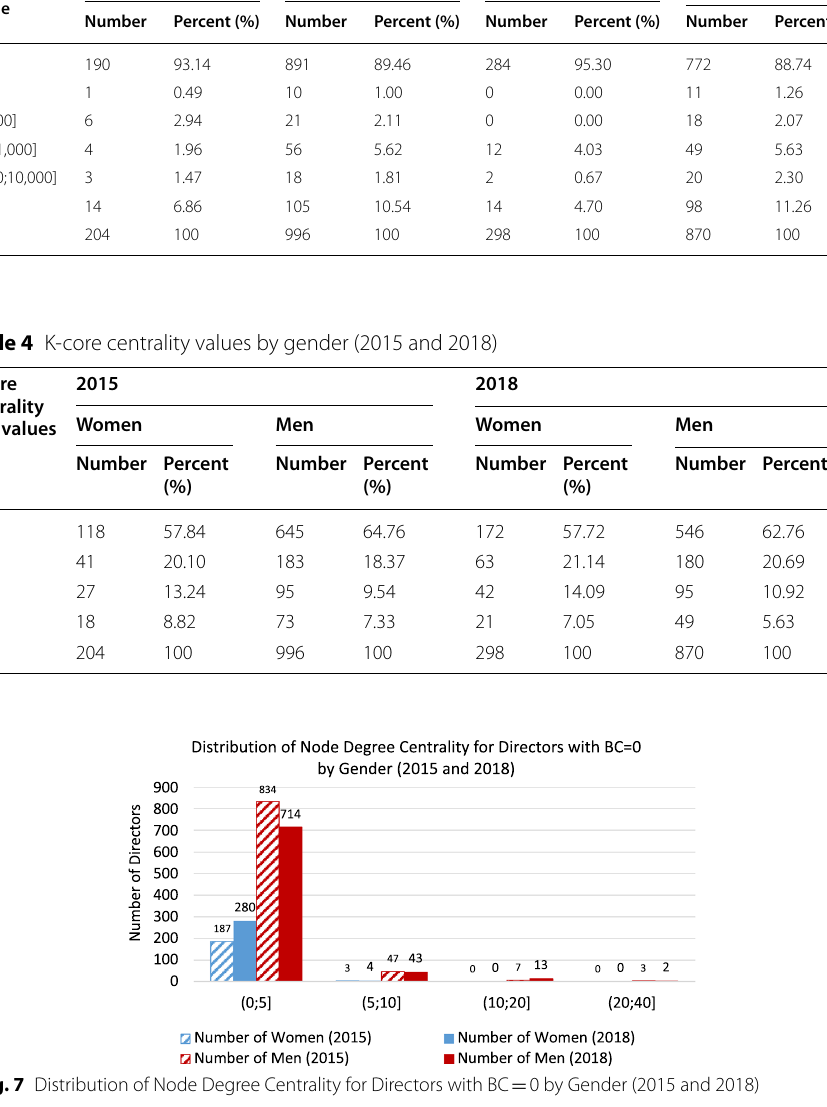
Table 3 Betweenness centrality ranges by gender (2015 and 2018) Betweenness centrality (BC) Range